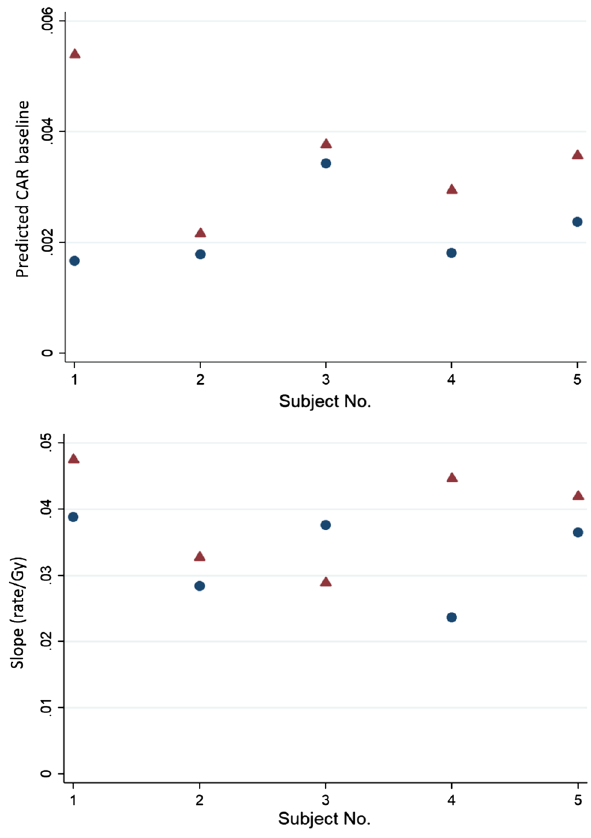
Figure 6. Background CAR (top panel) and average dose–response slope (Eq. 6) (bottom panel) prior to the first (blue circle) and second (red triangle) ISS missions for 5 repeated flyers. The background was about